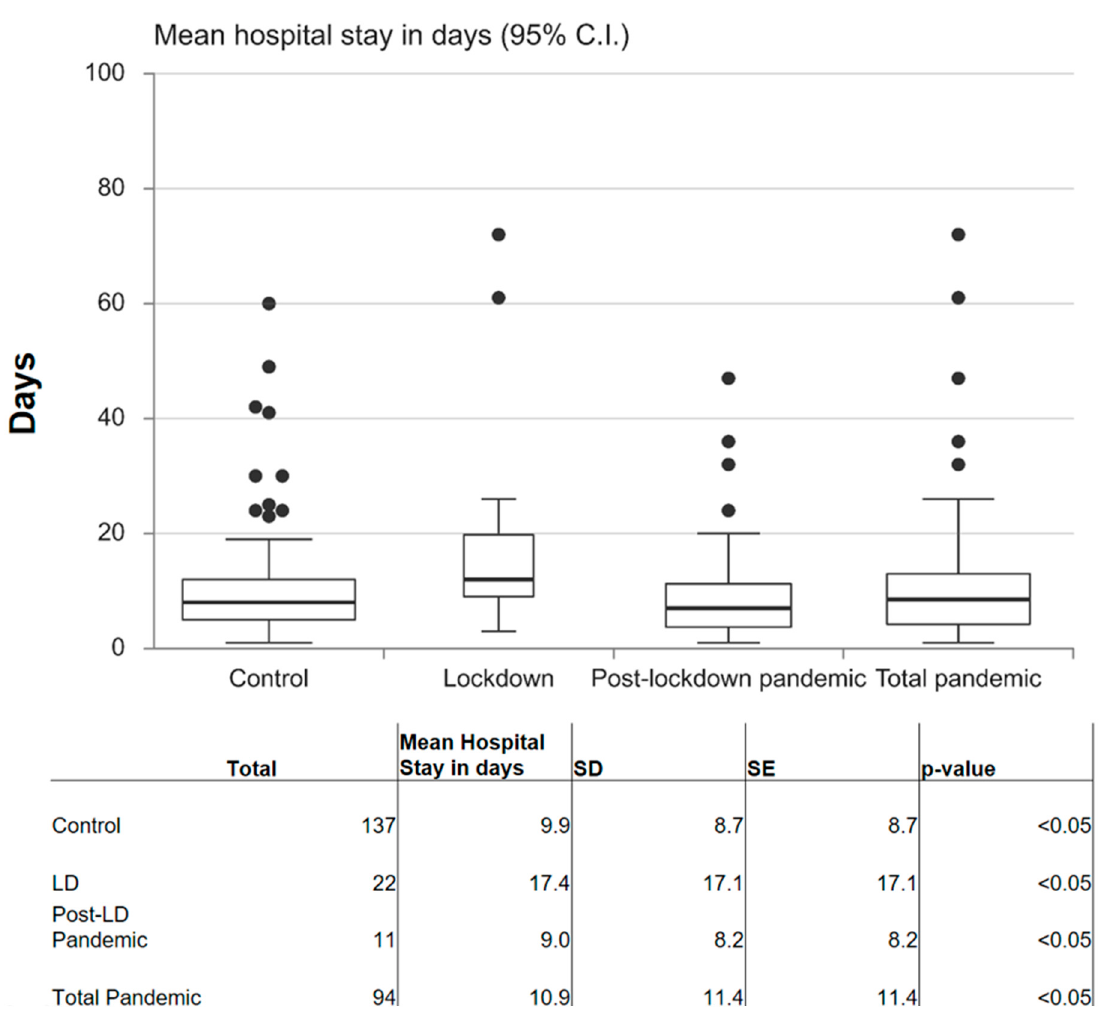
Figure 3. Box plot of hospital stay in days; 95% confidence interval; p < 0.05. CI: confidence interval; SD: standard deviation; SE: standard